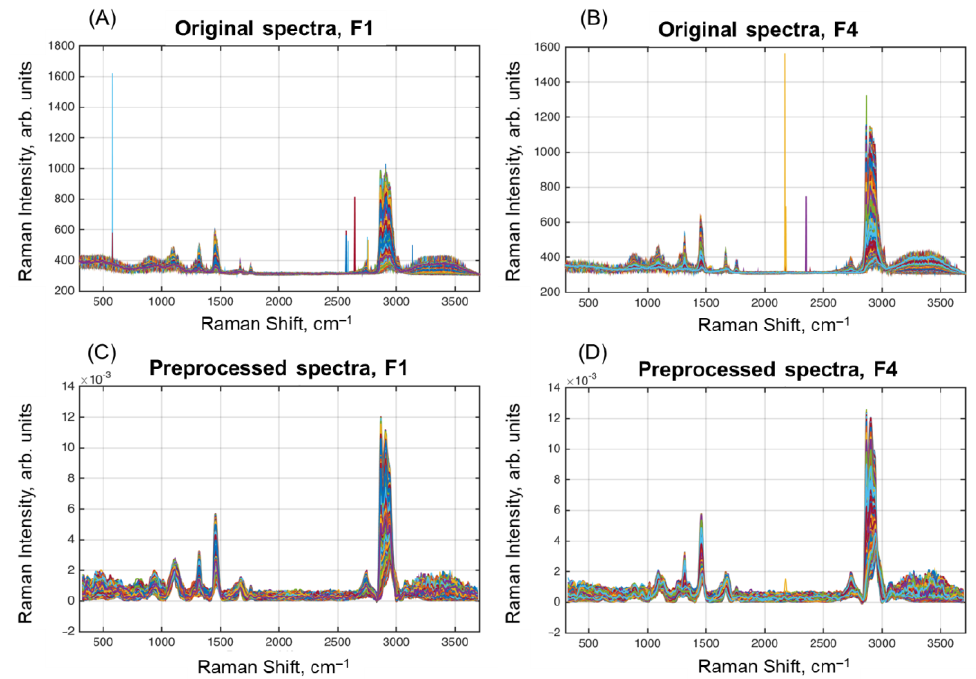
Figure 2. Original ( A , B ) and preprocessed ( C , D ) spectra of the samples F1 ( A , C ) and F4 ( B , D ).